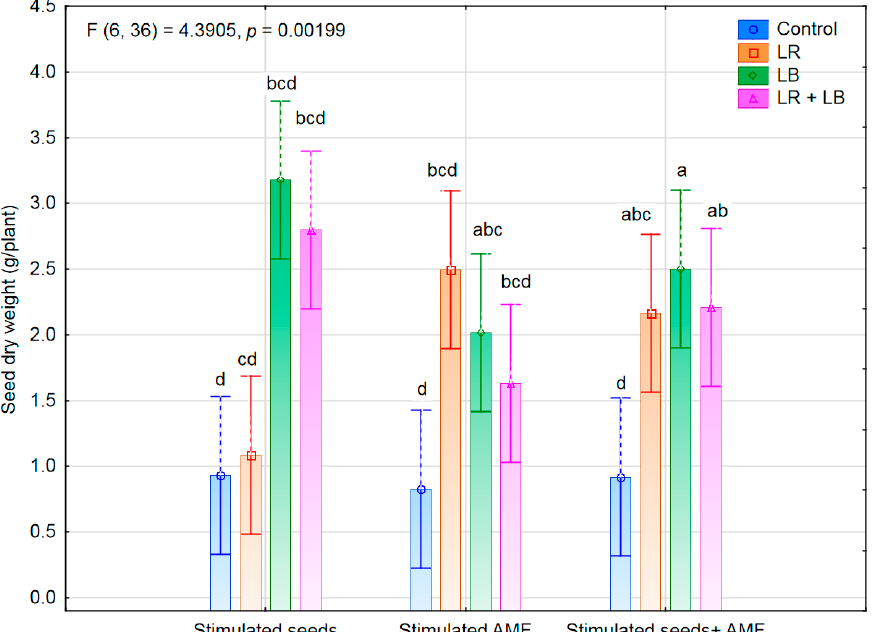
Figure 1. Effect of the interactions of the factors on the seed dry weight per plant. Different letters indicate the significant differences at p < 0.05.